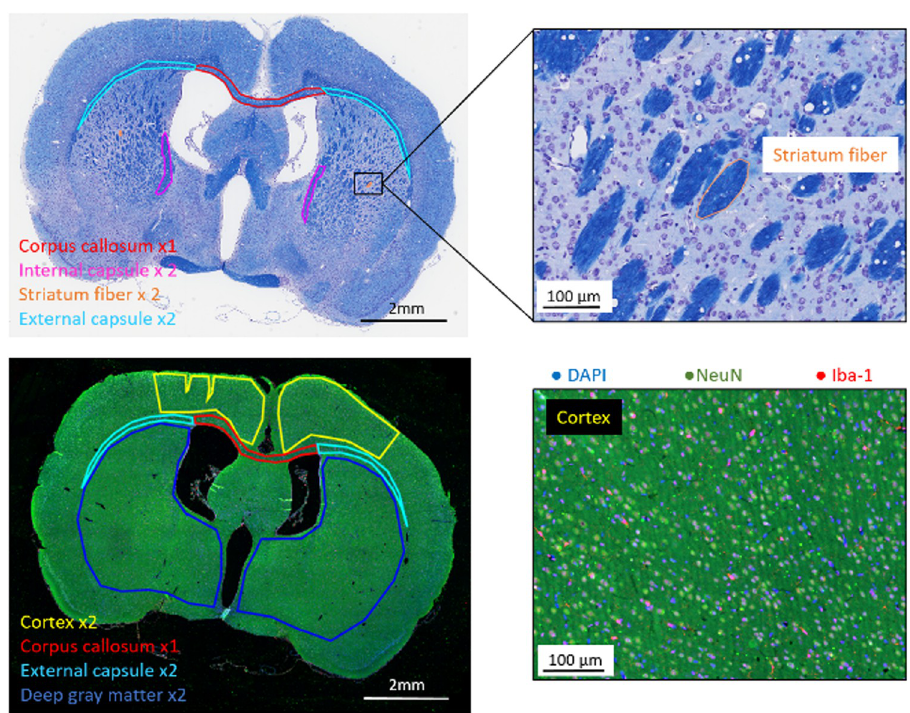
Fig 2. Typical histological sections of a poly (I:C) rat brain stained with luxol fast blue and cresyl violet (top row) and with Iba-1 (red), NeuN (green) and DAPI (blue) (bottom row) at 10 weeks after birth. Regions of interest are shown on the histological